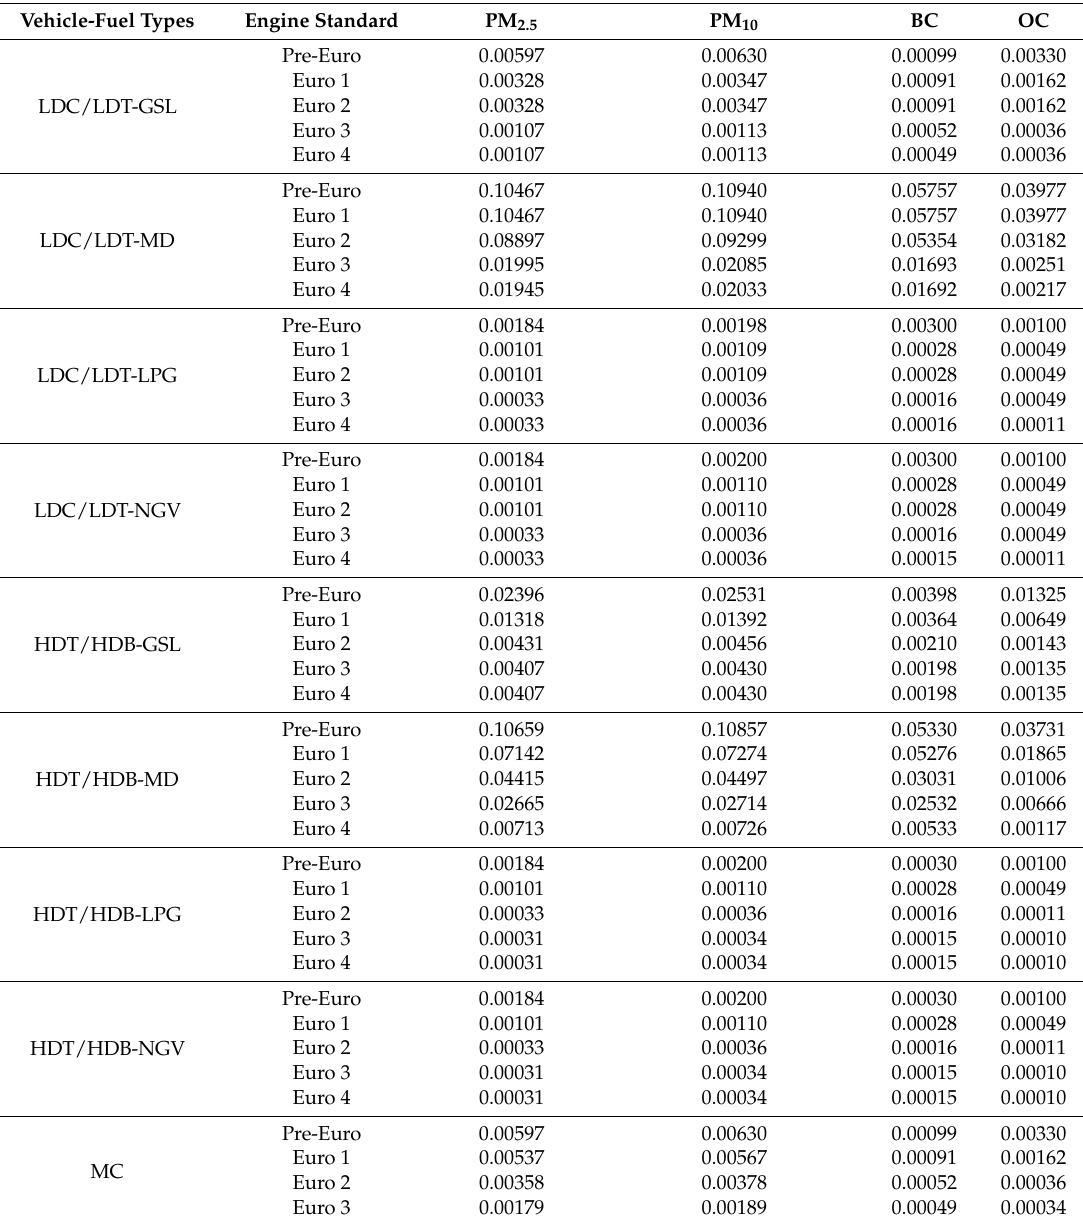
(d) Emission Factor of Particulate Matter (Unit: kt